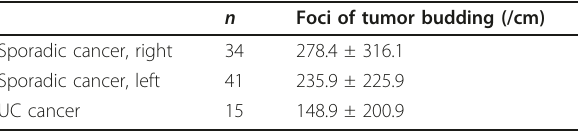
Table 5 Tumor budding in UC-associated and sporadic colon carcinomas n Foci of tumor budding (/cm) Sporadic cancer, right 34 278.4 ±